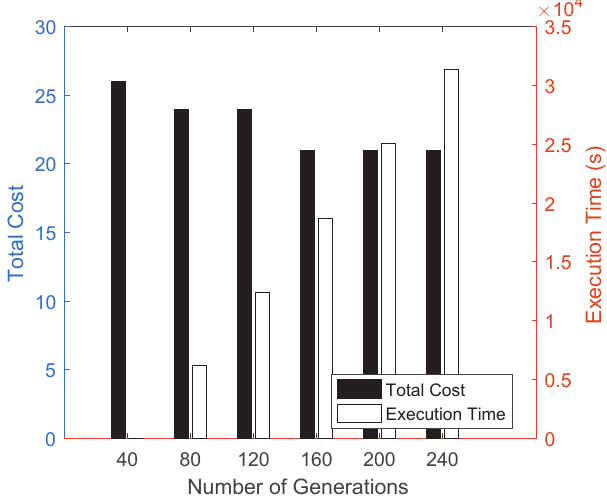
Figure 12. Performances along with a change of the number of generations.